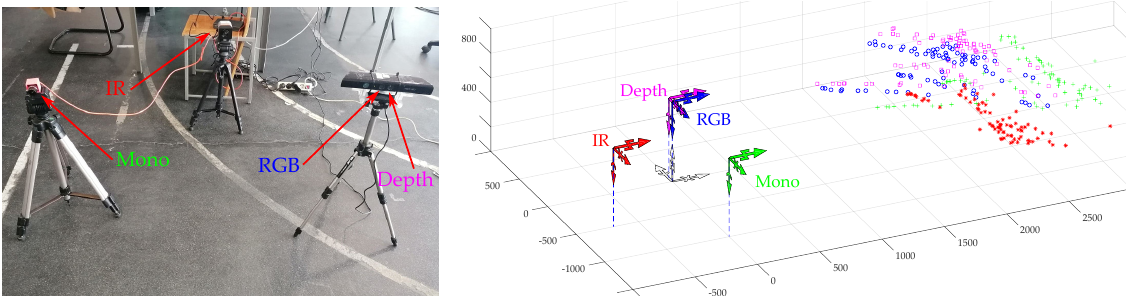
Figure 11. Example of another setup to collect data from sensors. On the right an actual collection of point cloud that shows serious defects making them mostly unusable for calibration. Units are in mm.